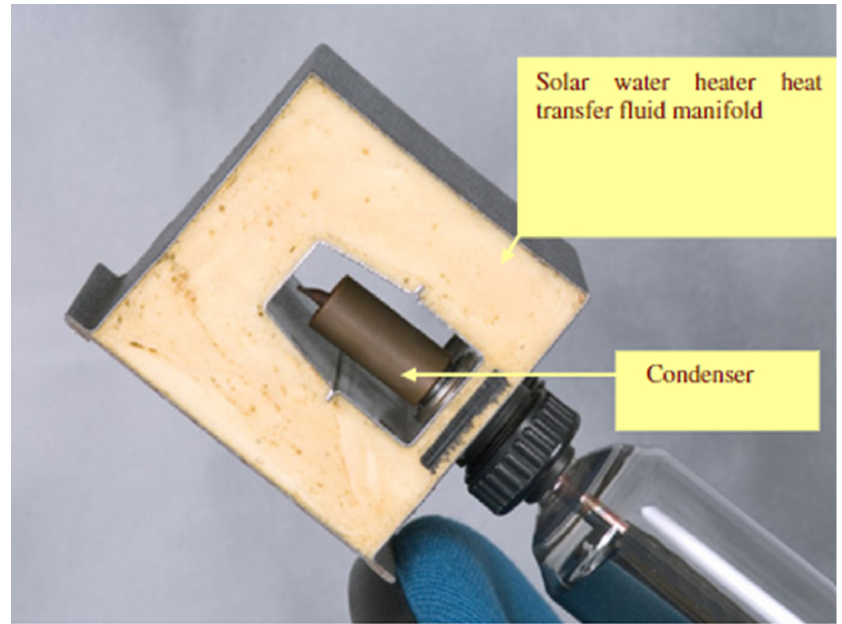
Figure 10. The ETC-SWH system with an internal condenser. Adapted with permission from ref. [91] 2012 Redpath.